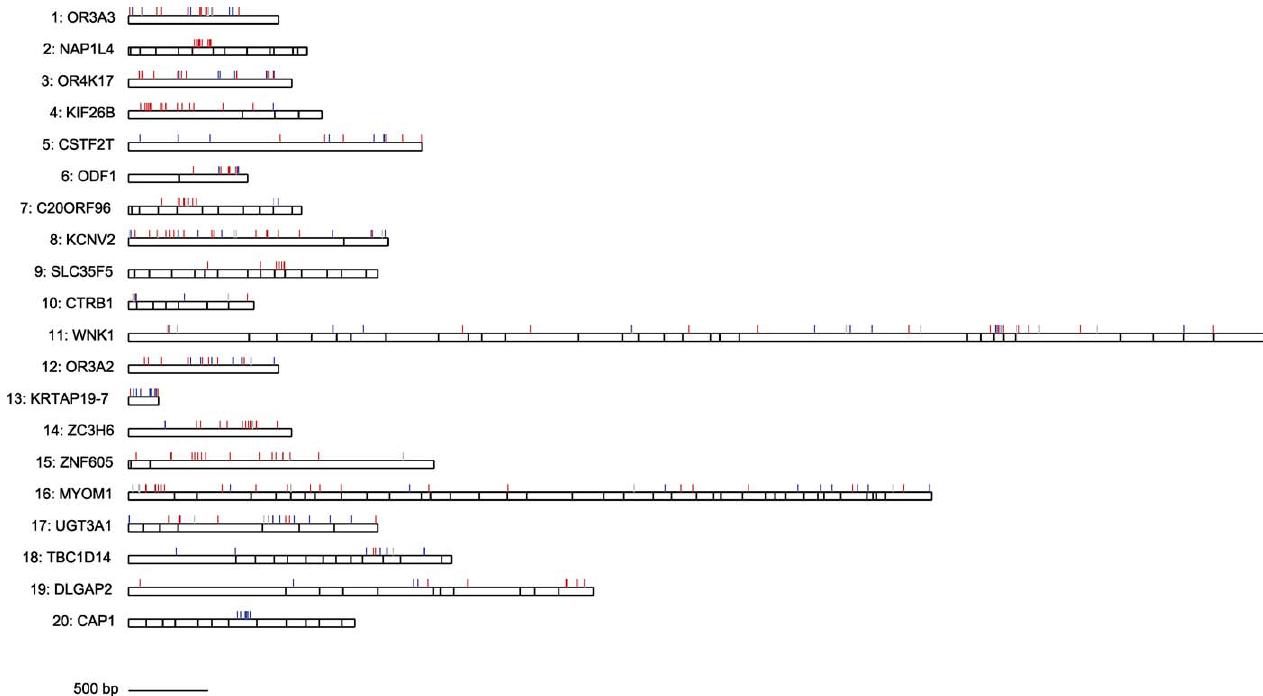
Figure 2. Genes Containing the Most Accelerated Exons Exon boundaries are marked with black lines. S ! W substitutions on the human lineage are marked with blue lines, W ! S substitutions on the human lineage are marked with red lines, and all other substitutions on the human lineage are marked with grey